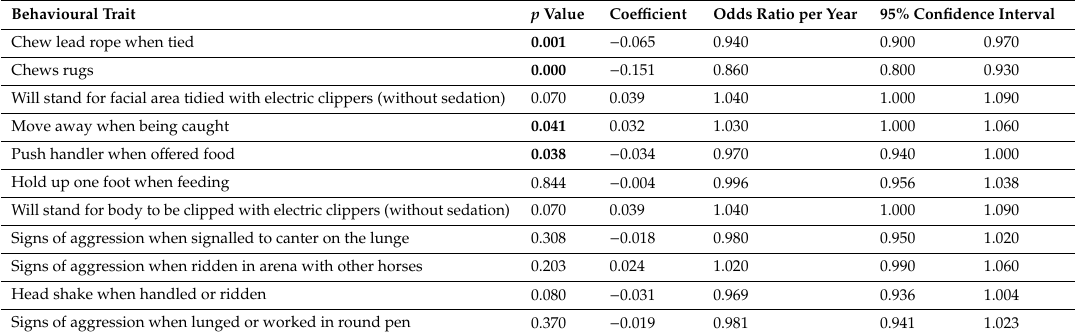
Table 4. Influence of age on 11 behavioural traits with at least 5% mean di ff erence scores between mares and geldings and univariate p < 0.2. Significant di ff erences appear in bold. Behavioural Trait